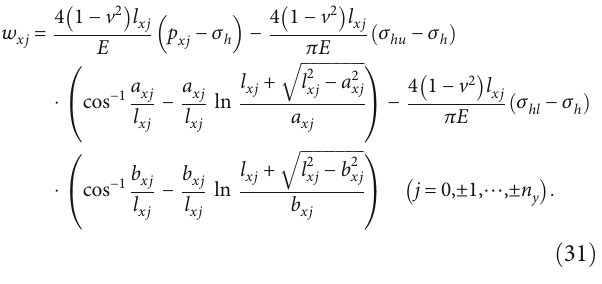
ffiffiffiffiffiffiffiffiffiffiffiffiffiffiffiffiffiffi q 2 − b l xj q ffiffiffiffiffiffiffiffiffiffiffiffiffiffiffiffiffiffiffi 2 − a l xj